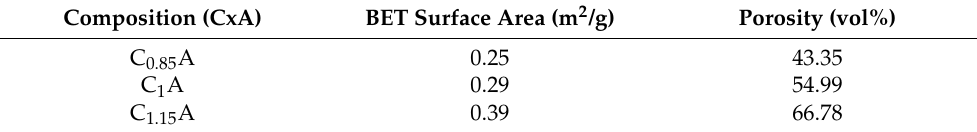
Table 3. BET surface area and porosity of different composition (C X A) pellets at 1150 ◦ C sintering.